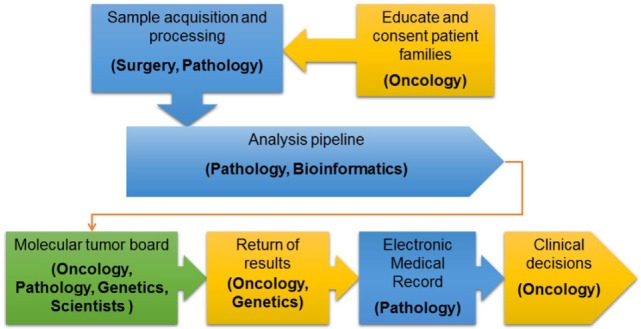
Overview of the precision in pediatric sequencing program clinical workflow.